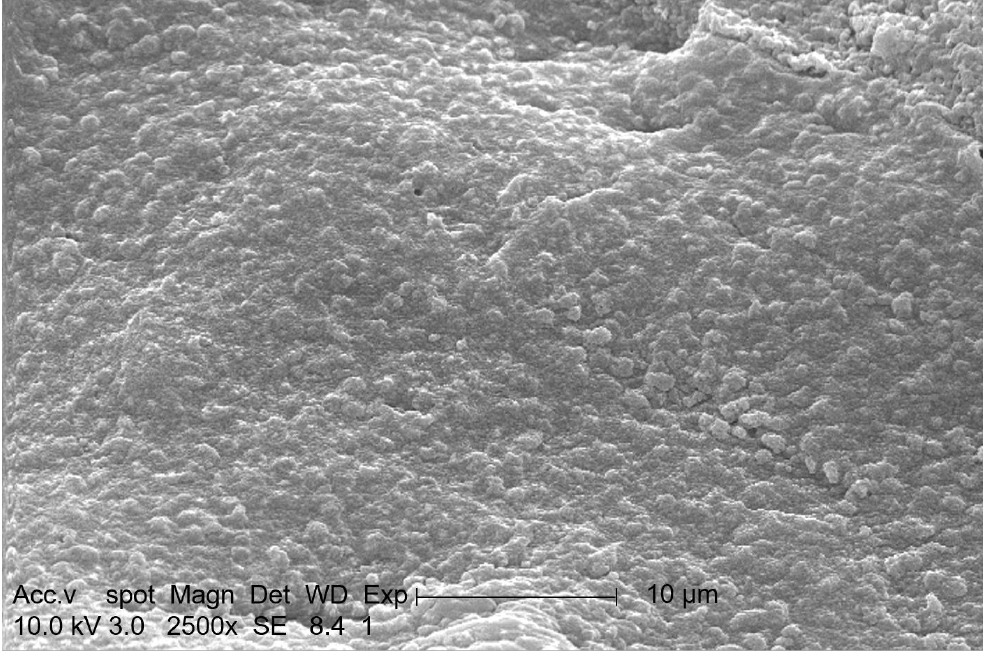
Figure 3. SEM image of the interior of the